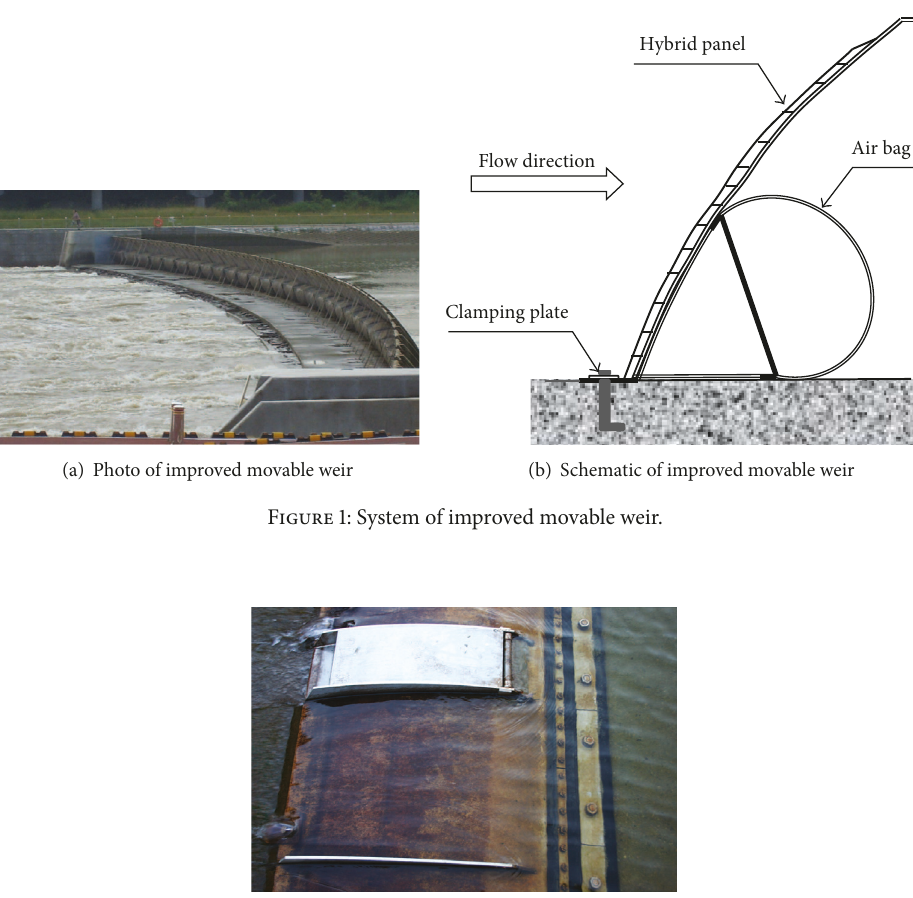
Figure 2: Corrosion of steel